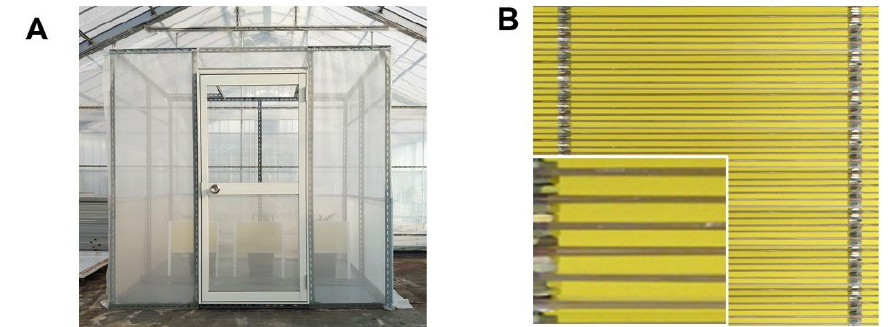
capturing assay. ( B ) An electrostatic insect catcher (EIC) furnished with a yellow board to attract phototactic insect pests. The insert in B shows an enlarged part of the